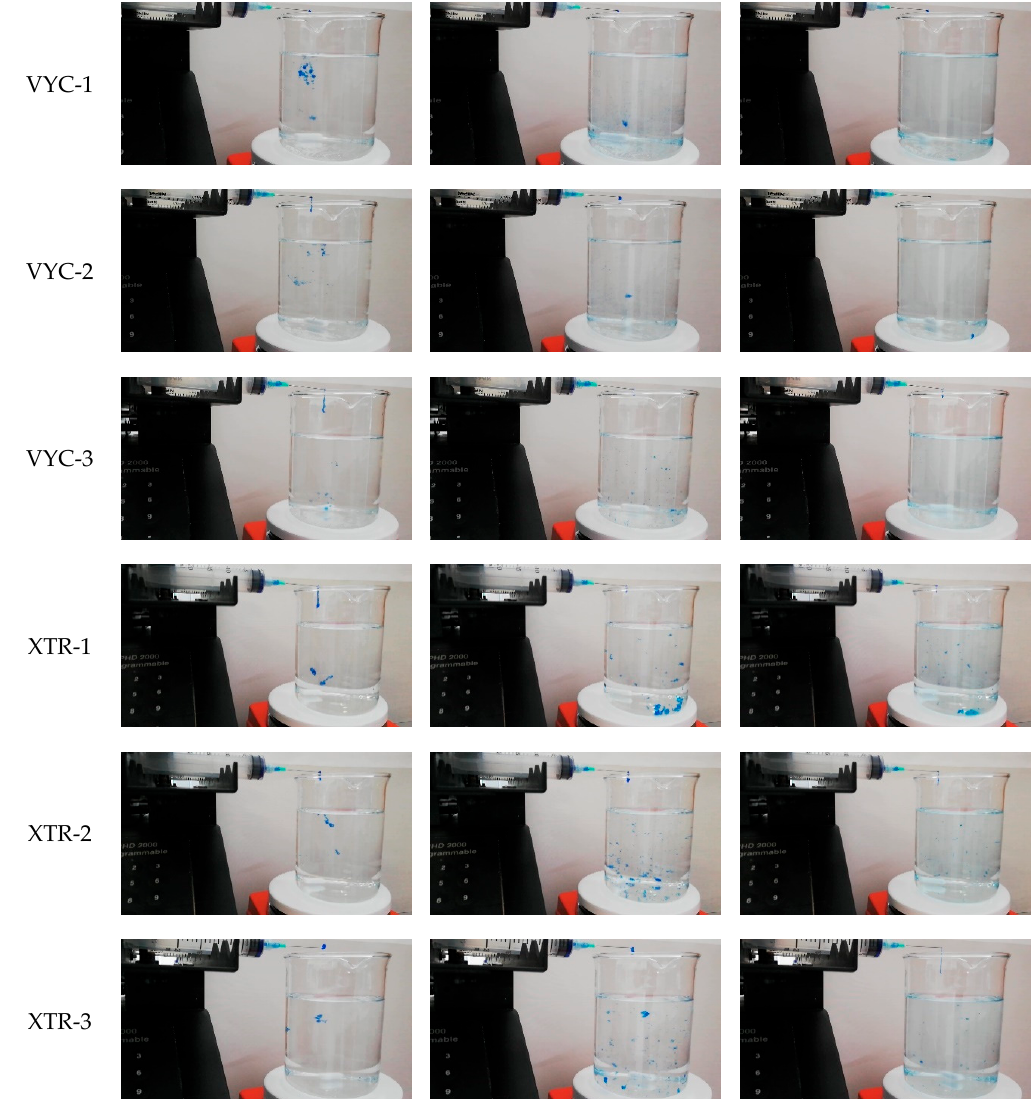
Figure 3. Gel dispersion in water at T = 0, 30 s, and 5 min of evaluated fillers.